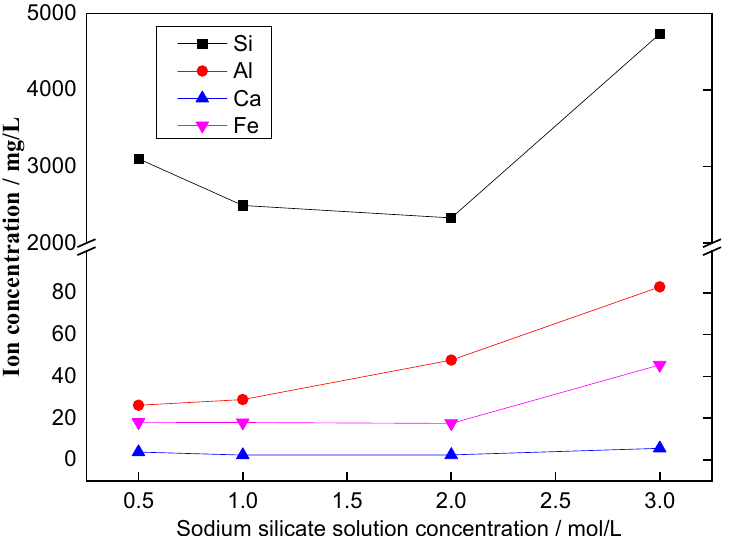
Figure 2. Effect of sodium silicate solution concentration on the dissolution of Si, Al, Ca and Fe.